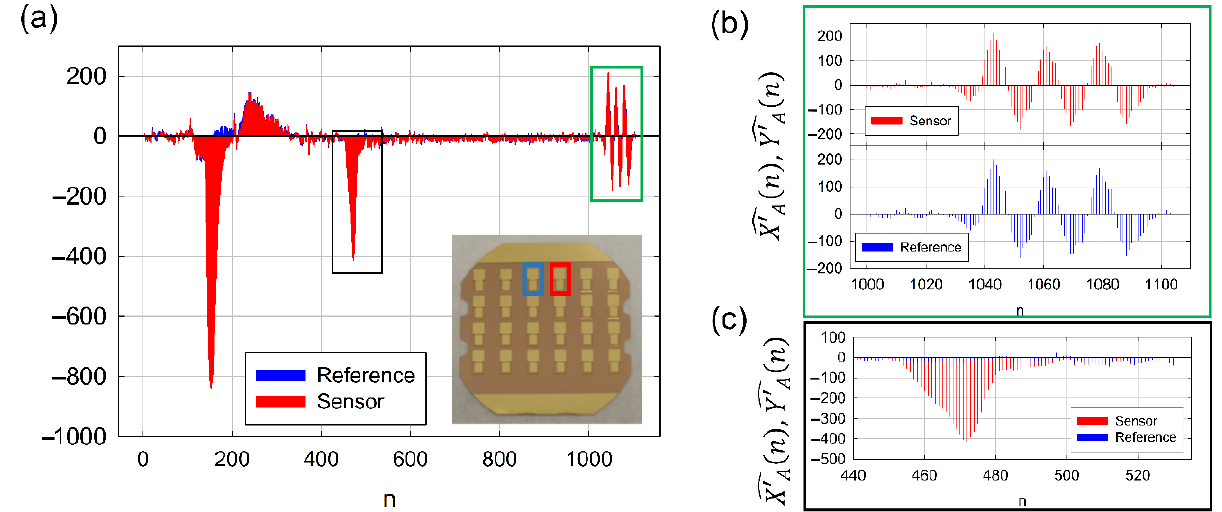
Figure 1. ( a ) Time derivative of the frequency shift approximation coefficients for the sensor (red) and the reference (blue); n refers to the sample index ( b ). Detailed view of the green inset in figure ( a ). ( c ) Detailed view of the black inset in figure ( a ).